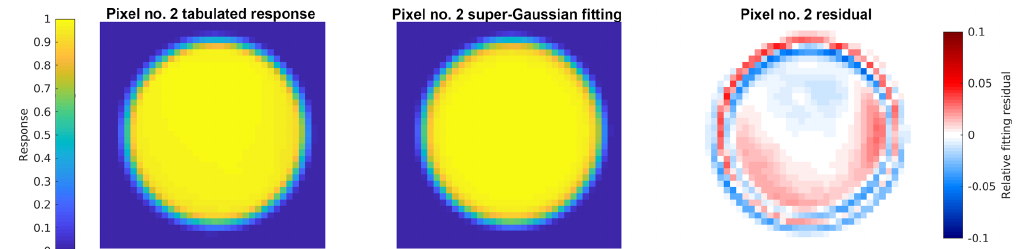
Figure A2. Fitting a tabulated IASI spatial response function for pixel no. 2 using rotating super Gaussian. The fitted exponent is 18.5.